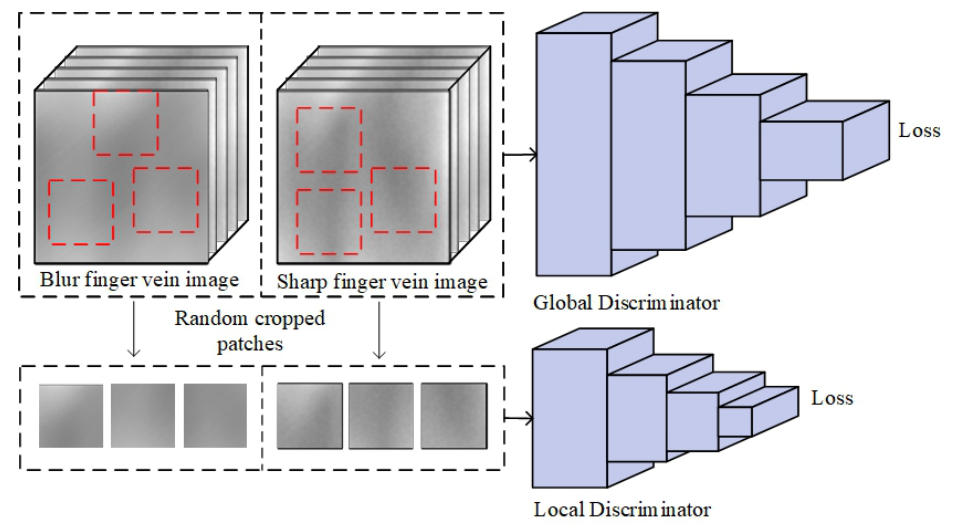
Figure 4. The DeblurGAN-v2 architecture of a